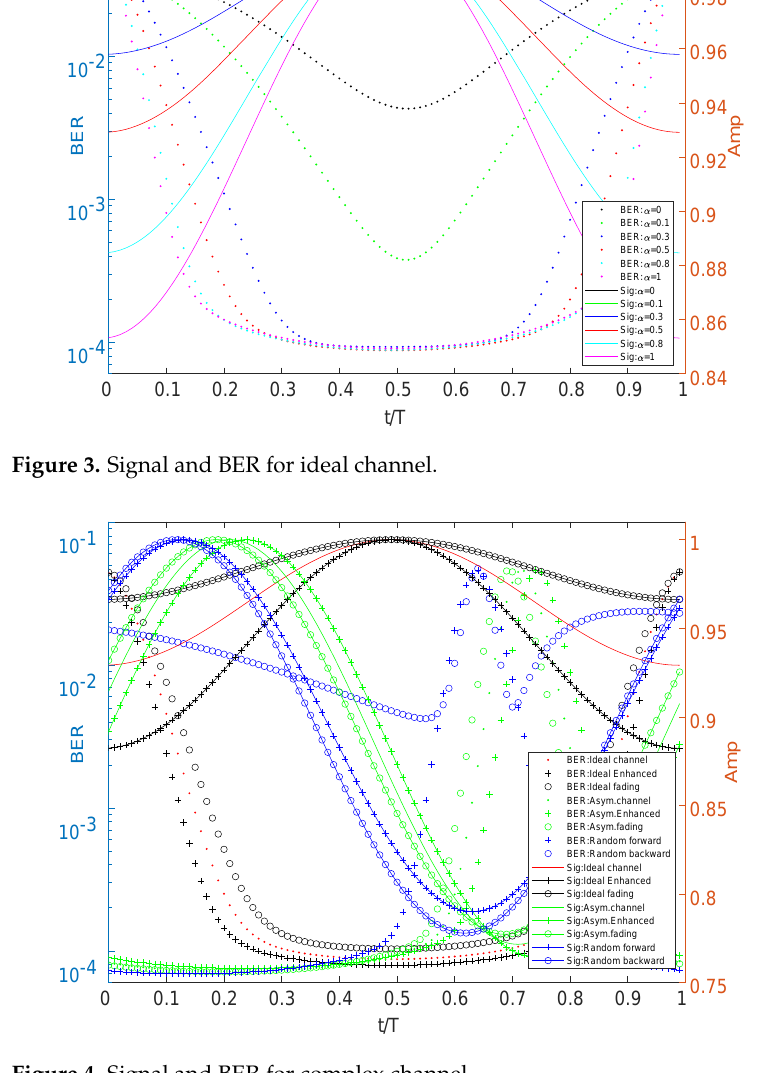
Figure 4. Signal and BER for complex